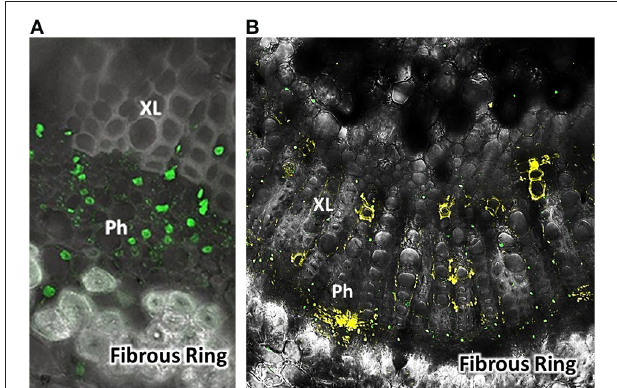
FIGURE 1 | Fluorescent labeled FANA (yellow) after delivery into citrus leaves [Sweet orange group, Madam vinous, Citrus sinensis (L.) Osbeck] (B) . Confocal microscope view as cross-section through leaf midrib near petiole. Control-Counter stain leaf cross-section. Green probe for nuclei used a tag fluorescence at 488nm wavelength, was Nuclear-Green TM (A) . Labels: Ph, Phloem; XL, Xylem; Fibrous Ring. Detection of FANA in Phloem and Xylem vessels. Sample image 7 days after treatment. FANA-probe treatment was a 6.93 nmol concentration in 500 µ L water, absorbed into detached citrus leaves. Image view ∼ 40X. Images were taken with a Zeiss LSM510 Confocal